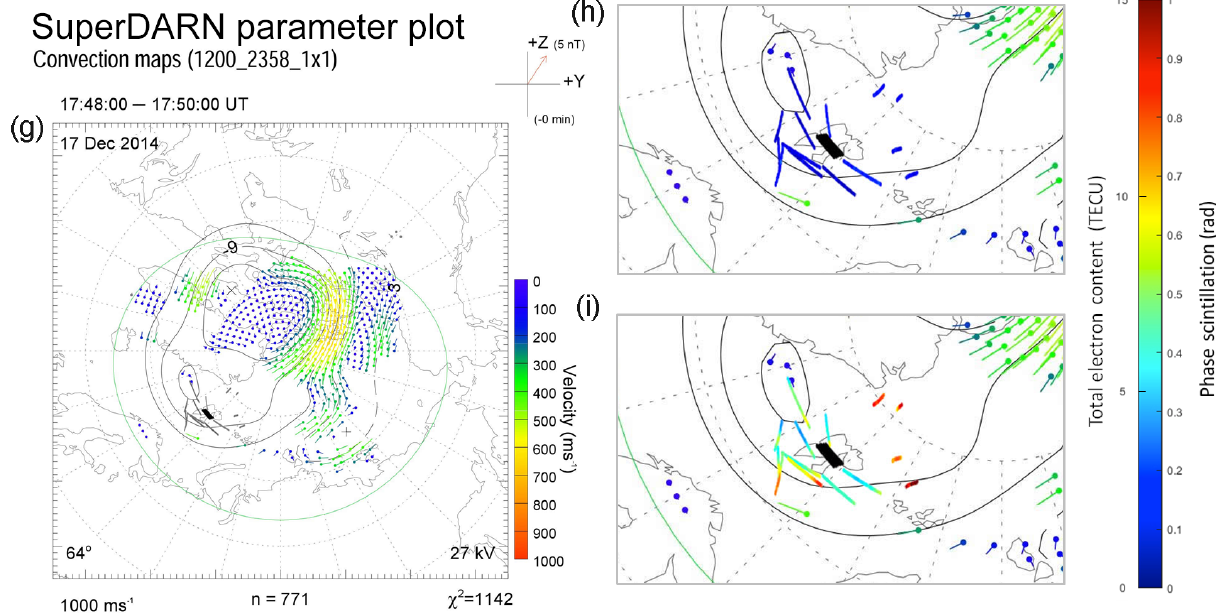
Figure 5. Electric potential patterns inferred from the SuperDARN radars for 16:28, 17:14, and 17:48UT on 17 December 2014 as a function of geomagnetic latitude and magnetic local time. Magnetic noon is shown at the top of panels (a) , (d) , and (g) , with dusk and dawn on the left- and right-hand sides respectively and magnetic midnight at the bottom. Magnetic latitude is indicated by the grey dashed circular lines at 10.0 ◦ increments. The grey lines show the location of satellite passes from GNSS satellites, assuming an ionospheric intersection of 350km. The SuperDARN plot from 16:28UT includes satellite passes from 16:00 to 16:58UT, the 17:14UT plot includes satellite passes from 16:58 to 17:28UT, and the 17:48UT plot includes satellite passes from 17:28 to 18:02UT. These time intervals were chosen as the inspection of the whole SuperDARN data set at a 2min resolution indicated that the convection patterns were relatively stable during these intervals. Panels (b) , (c) , (e) , (f) , (h) , and (i) show the area around the satellite passes in more detail. Colours represent phase scintillation (b, e, h) and TEC (c, f, i) . The thick black line indicates the position of the polar hole observed using the 42m dish of the EISCAT Svalbard